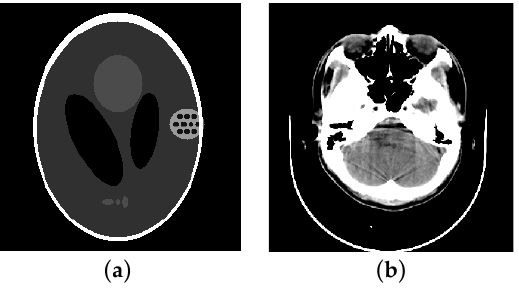
Figure 2. Head phantoms for simulation: ( a ) The 128th slice of modified 3D Shepp–Logan head phantom; ( b ) a selected slice of head phantom.